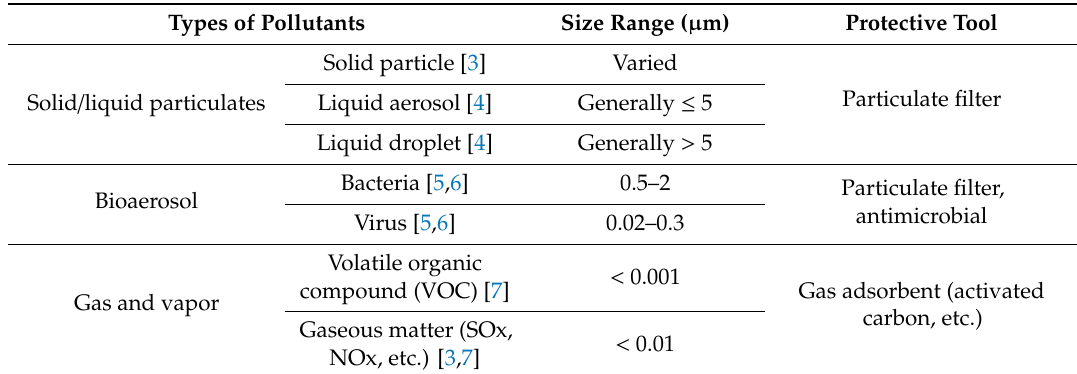
Table 1. Airborne pollutants [3–7].